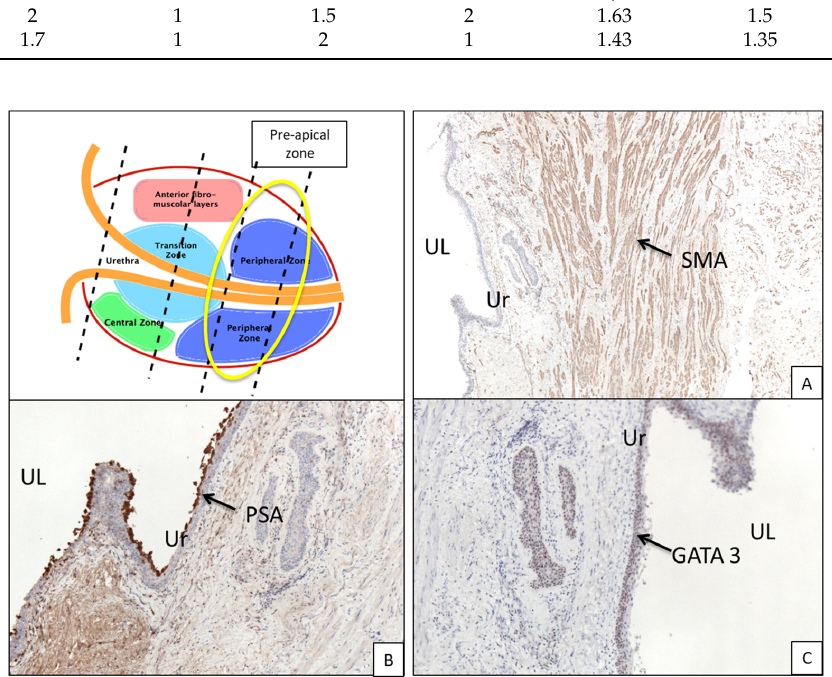
Figure 5. ( A ) Smooth muscle actin immunohistochemical staining shows the fibromuscular compo- nent of prostatic apex, underlining the fascicular disposition of fibers (arrow, 10× magnification). ( B ) PSA immunohistochemistry shows positivity in urethral epithelial lining (arrow, 10× magnifi- cation), and coexpression of GATA 3 ( C ) is also present (arrow, 10× magnification). UL, urethral lumen; Ur, urothelium; PG, prostatic glands; Ch, chorion; SM, smooth muscle; SMA, smooth muscle actin. In all six specimens, the distribution of chorion thickness is homogeneous, with only slight variations, mainly at the level of the post-basal and pre-apical sections, as shown in Figure 6.